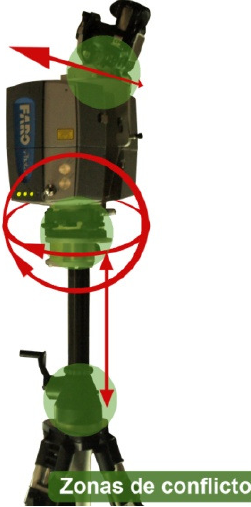
Figure 18. Possible weak points in the Photon setup. The geared column clamp might not be tight enough to fully avoid any vertical displacement or even tilt of the whole set.